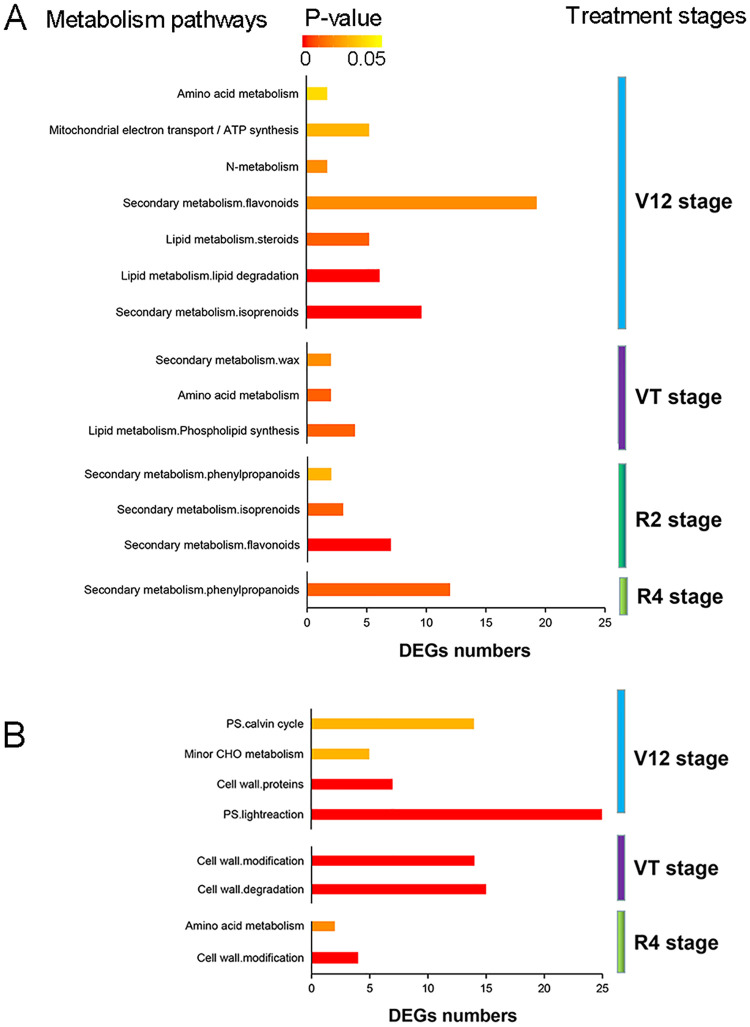
Metabolic pathways enrichment analysis of DEGs.Most significantly enriched metabolic pathways in (A) drought tolerant hybrid cultivar ND476, and (B) drought sensitive hybrid cultivarZX978, based on the hypergeometric test, p < 0.05.